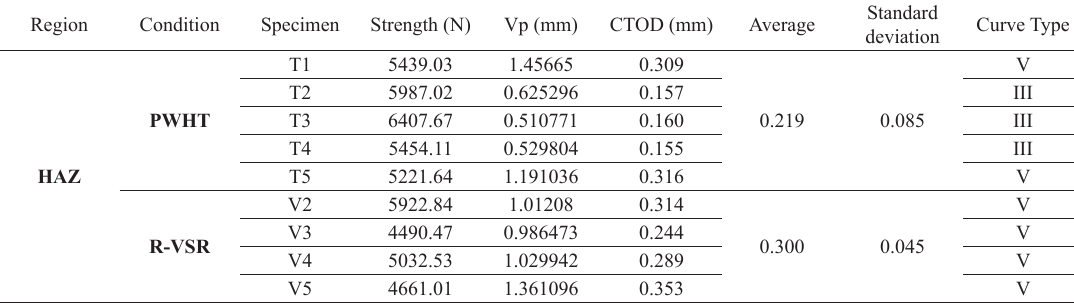
Table 7. CTOD test results of the evaluated conditions.